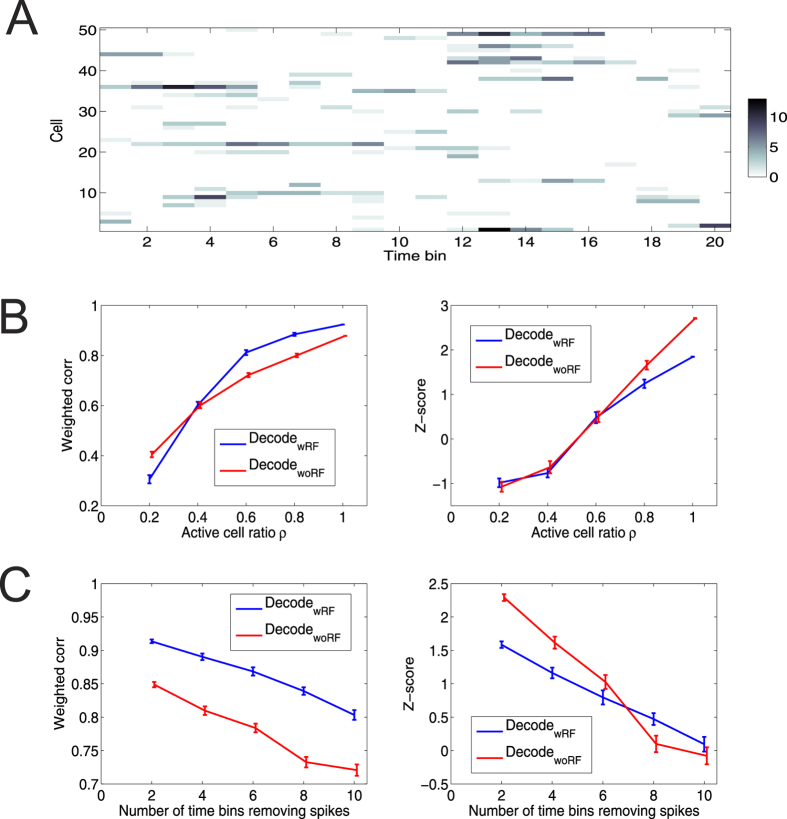
Comparison of detection reliability between DecodewRF and DecodewoRF.(A) Segment of a spike count matrix with 20 temporal bins. (B,C) Weighted correlation (Left) and Z-score (Right) for varying active cell ratio ρ (B) and for removing spikes across different number of bins (C). Error bar denotes SEM (n = 50 Monte Carlo runs).